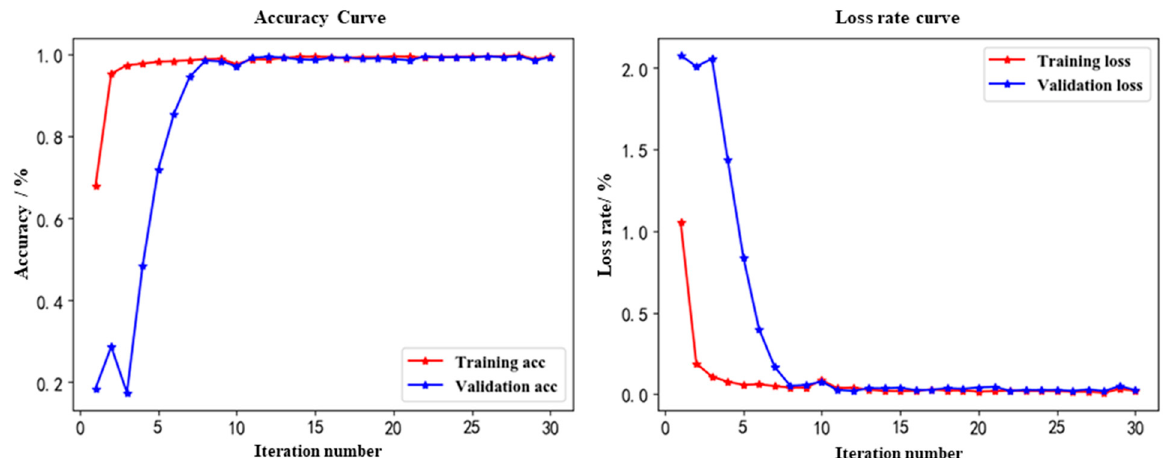
Figure 11. Training result.